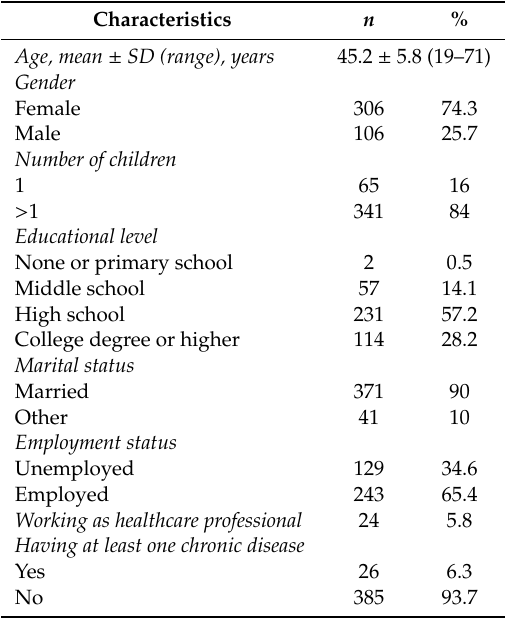
Table 1. Main characteristics of the study